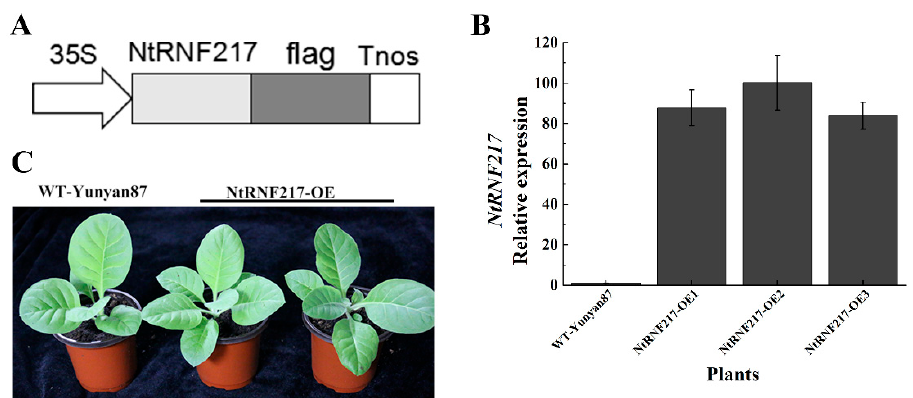
Figure 3. Generation of NtRNF217 -overexpressing tobacco plants. ( A ) Schematic diagram of the 35S::NtRNF217-flag fusion protein construct. ( B ) The relative transcripts of NtPRNF217 in transgenic plants and WT-Yunyan87 plants were tested by qRT-PCR. ( C ) Physiological phenotypes of NtRNF217 -OE and WT-Yunyan87 plants.